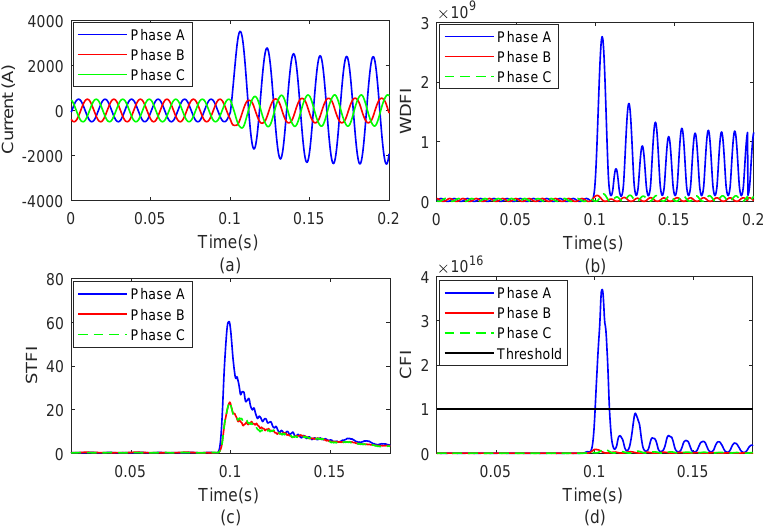
Figure 4. Detection of fault incident between phase A and ground ( a ) current waveform ( b ) WDFI ( c ) STFI ( d ) CFI.